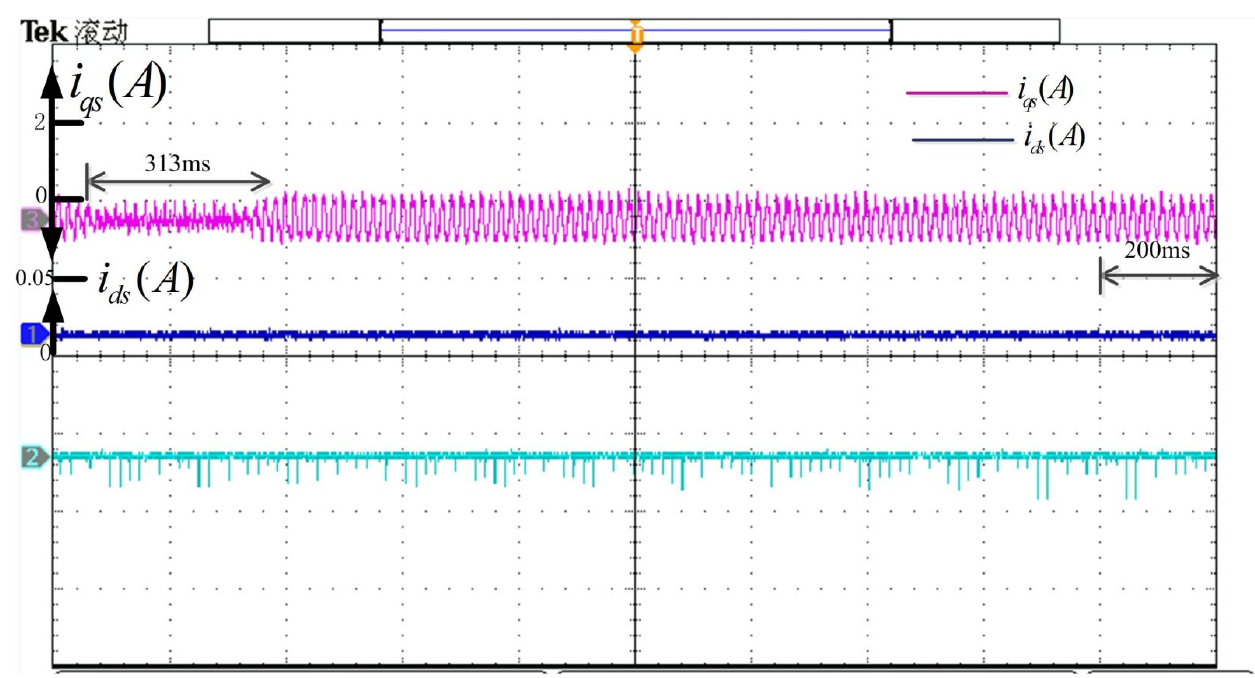
Figure 6. The validation results of the traditional PI + PID control for the abrupt load torque change of system parameters under inductance parameters